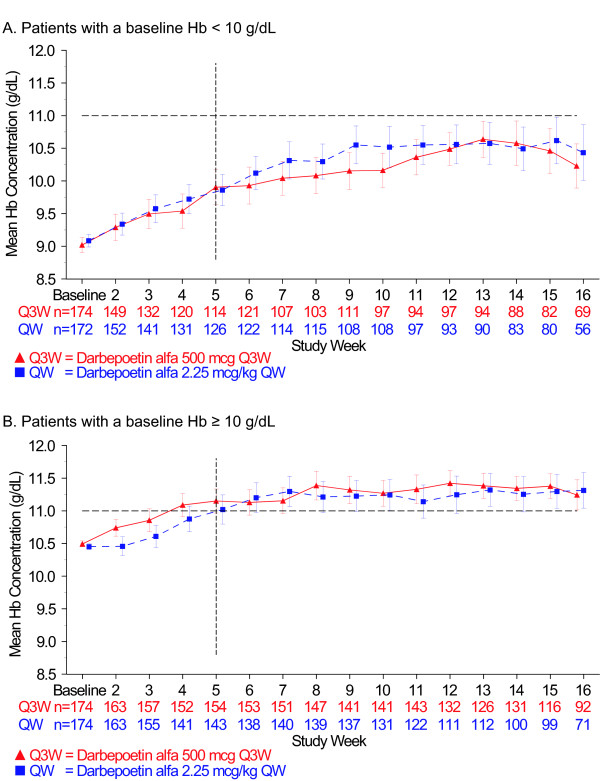
Hemoglobin profile over the treatment period. The mean hemoglobin (Hb) concentration (g/dL) is shown over time in weeks. The treatment period lasted through the earlier of day 109 or end of study. Error bars represent the 95% confidence intervals. The dotted, black horizontal line marks the 11 g/dL Hb level on the Y axis, and the dotted, black vertical line marks week 5 on the X axis. A. Patients with a baseline Hb level < 10 g/dL. B. Patients with a baseline Hb level ≥10 g/dL